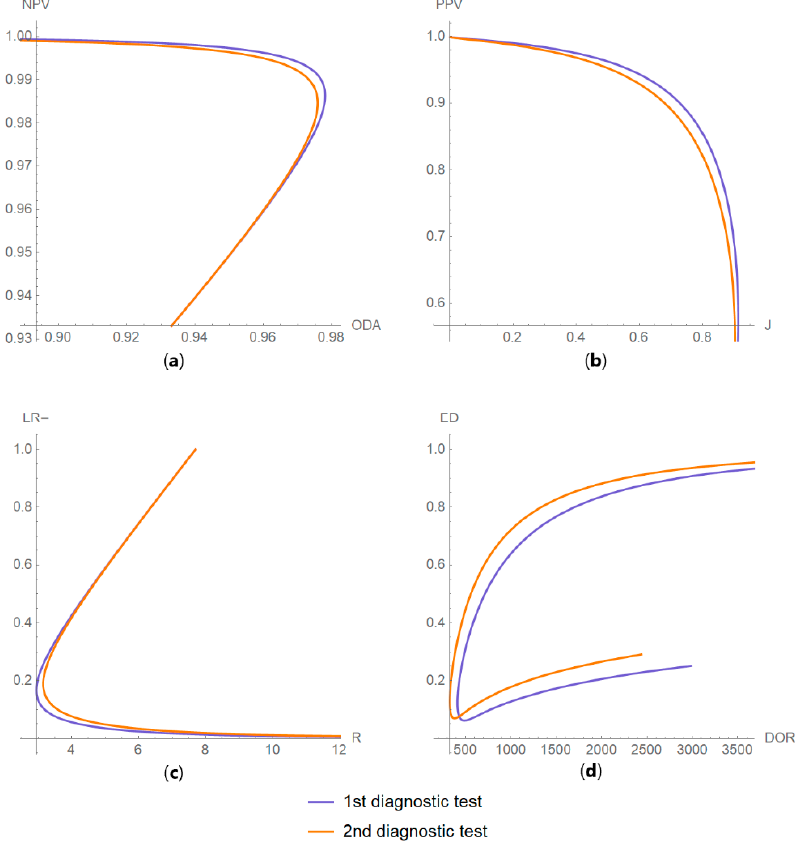
Figure 17. DAM relations plots. Plots of the relations between ( a ) negative predictive value ( NPV ) and overall diagnostic accuracy ( ODA ); ( b ) positive predictive value ( PPV ) and Youden’s index ( J ); ( c ) likelihood ratio for a negative result ( LR − ) and risk ( R ); and ( d ) Euclidean distance ( ED ) and diagnostic odds ratio ( DOR ), of two diagnostic or screening tests measuring the same measurand with different uncertainties, with the respective parameters in Table 4.